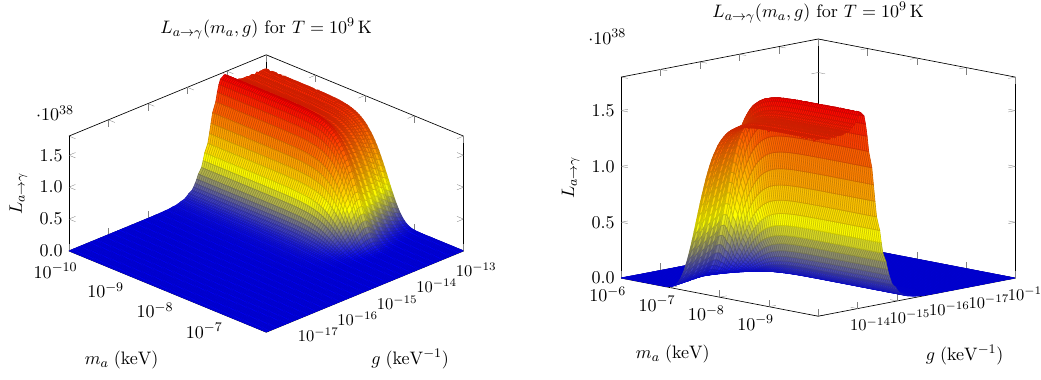
Figure 4 . Photon luminosity from ALP-photon oscillations in the broad band from 1 keV to 200 keV in the ( m a ; g ) plane. The computations are done for SGR 1806-20 assuming r 0 = 10 km and B 0 = 20 10 14 G. The magnetar core temperature is assumed to be T = 10 9 K. The two (cid:2) panels show the same conversion probability from di(cid:11)erent points of view.